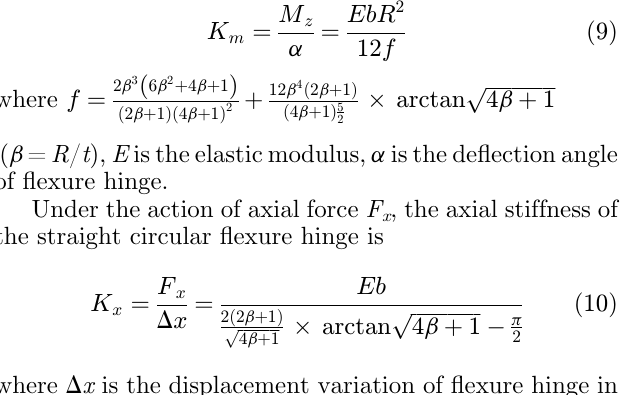
Fig. 5. Stress diagram of the differential lever ampli fi cation